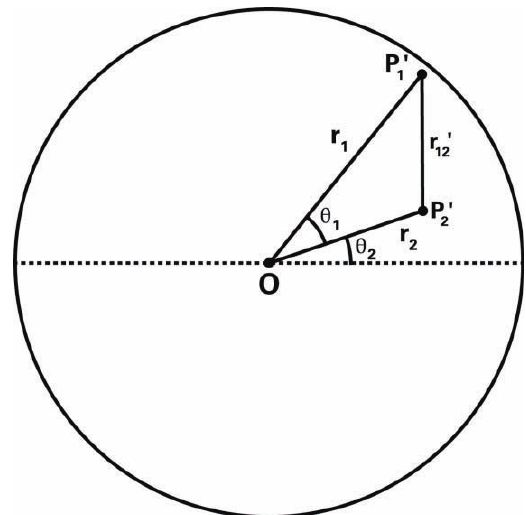
Figure 1: Polar coordinates ( ) and ( ) of the projected integration points